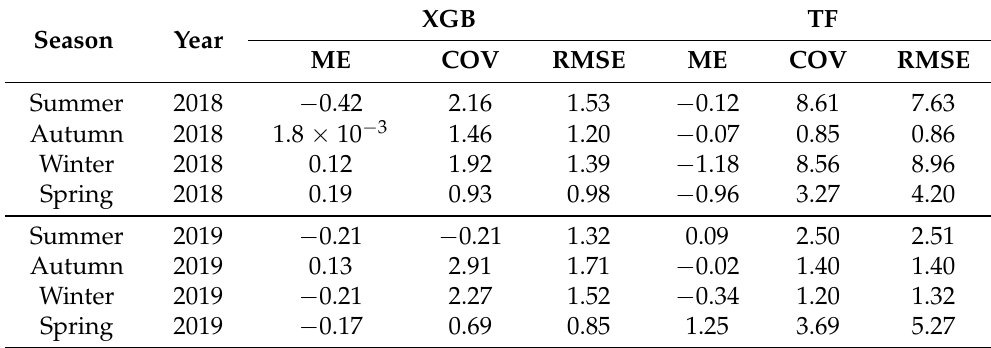
Table 5. Performance evaluation for XGB and TF